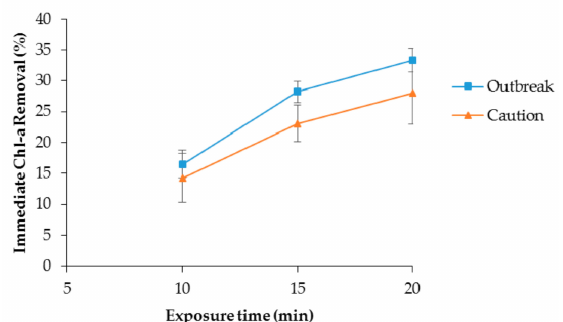
Figure 2. Immediate effect of sonication on the mixed algae suspension for the outbreak and cation levels.